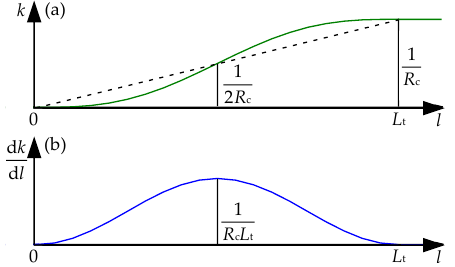
Figure 6. ( a ) Relation curves between the curvature and the arc length; ( b ) Relation curves between the curvature derivative and the arc length.